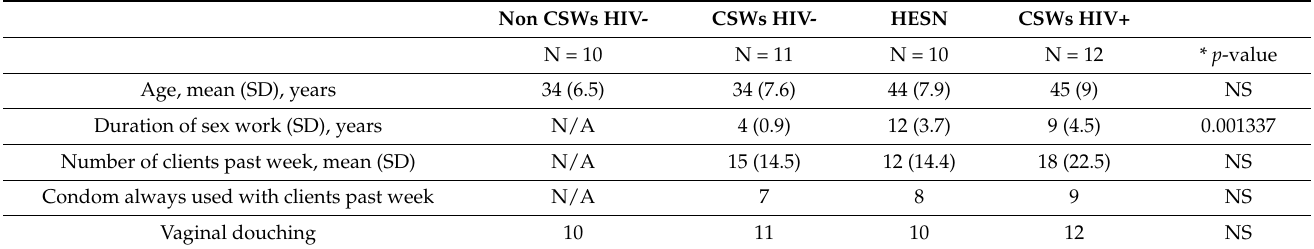
Table 1. Distribution of demographic and sexual behavior characteristics in HIV-1